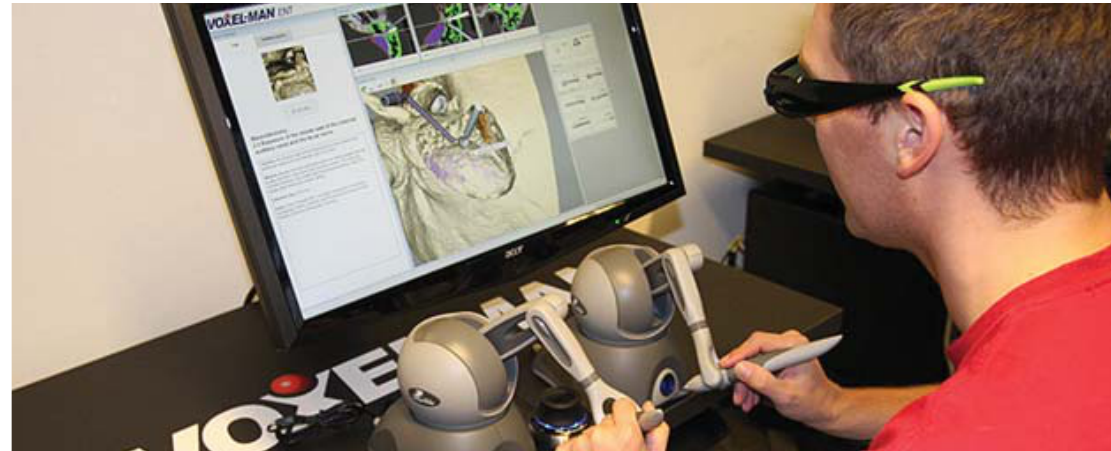
Figure 1. VOXEL-MAN Tempo 3D Surgical